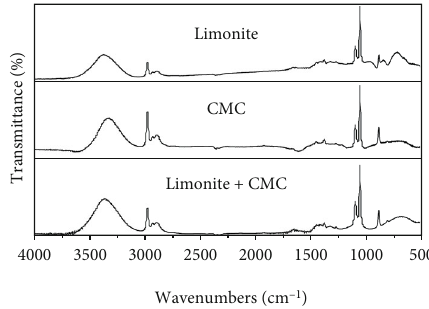
Figure 17: FTIR spectra of limonite and CMC.